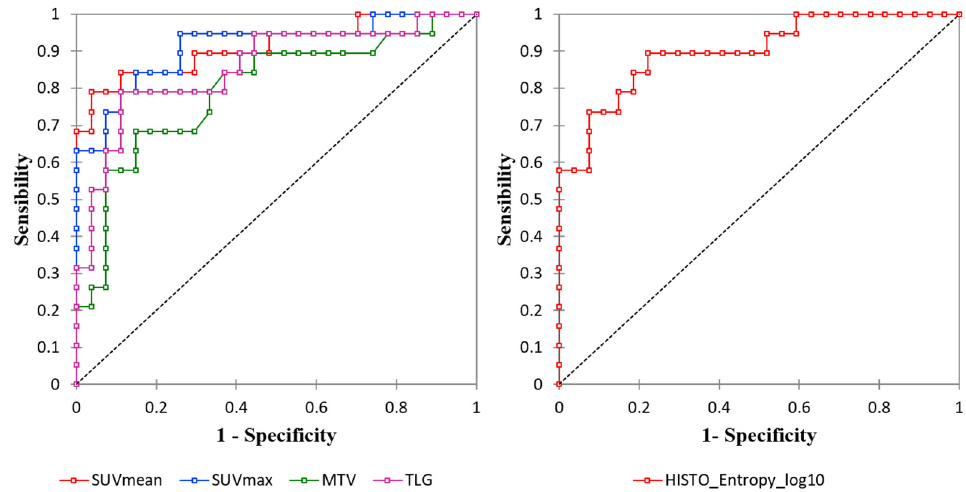
Figure 1. Receiver operating characteristics (ROC) curve analysis of the conventional and volumetric PET parameters (left) and Histo_Entropy_log10 (right).